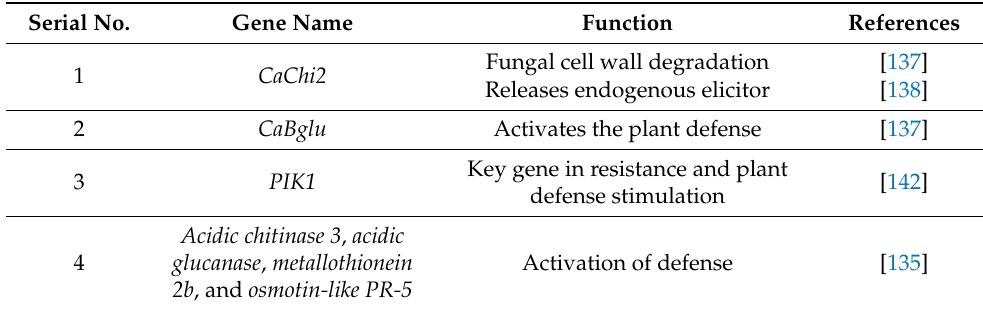
Table 6. Genes involved in plant defense mechanisms against fusarium wilt in chilies. Serial